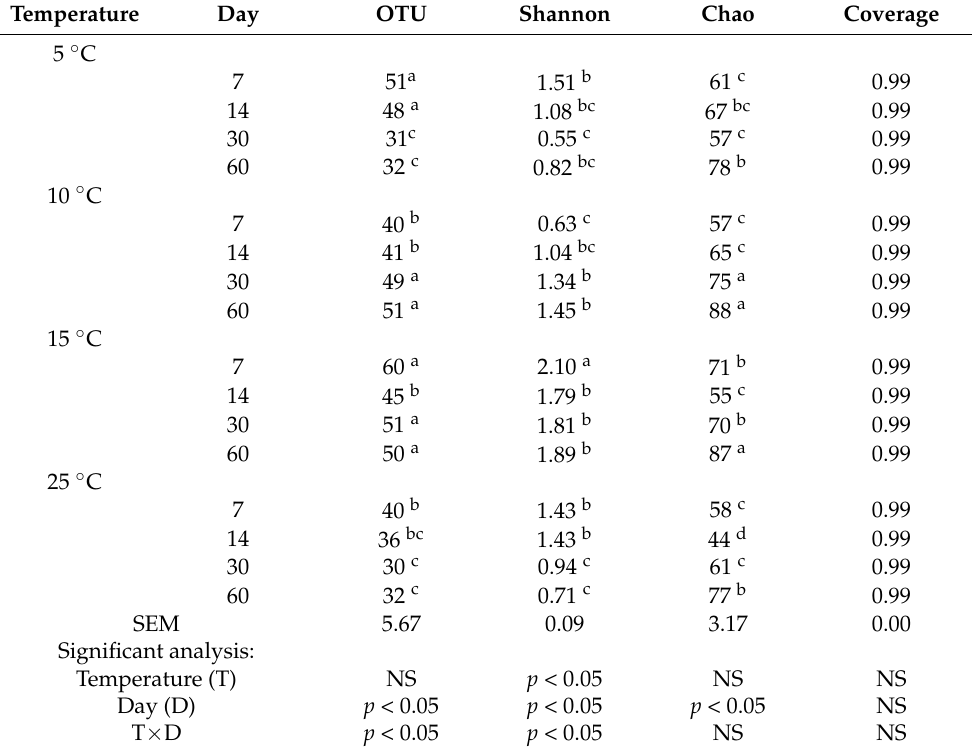
Table 3. Alpha diversity of oat silages at different temperatures during ensiling process. Temperature Day OTU Shannon